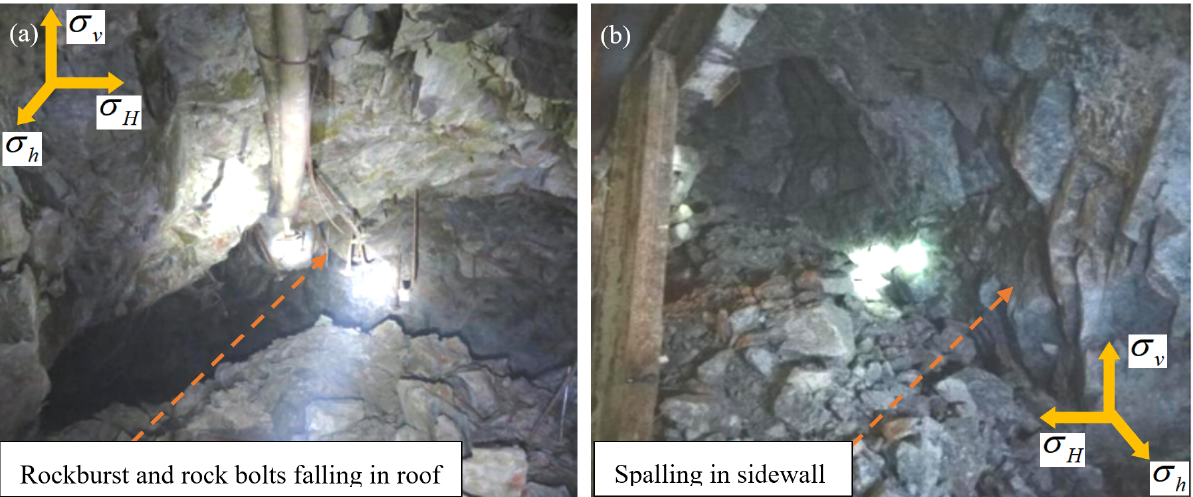
Figure 19. Tunnel failure at buried depth − 830 m of a gold mine. ( a ) rockburst and rock bolts fall- ing in roof; ( b ) spalling in sidewall. in roof; ( b ) spalling in